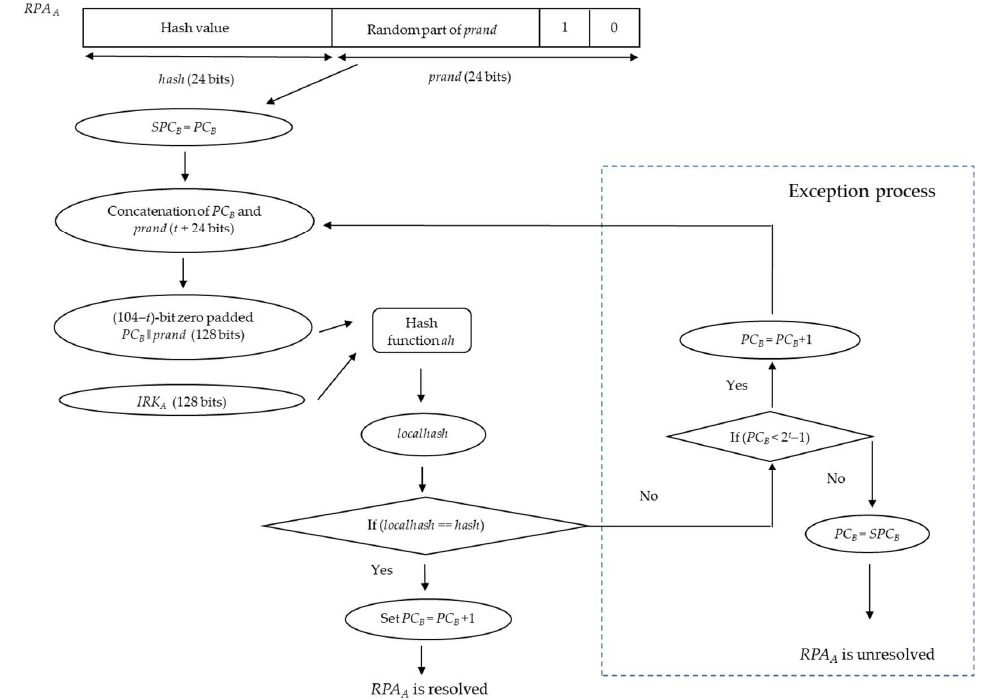
Figure 11. Improved RPA resolution.